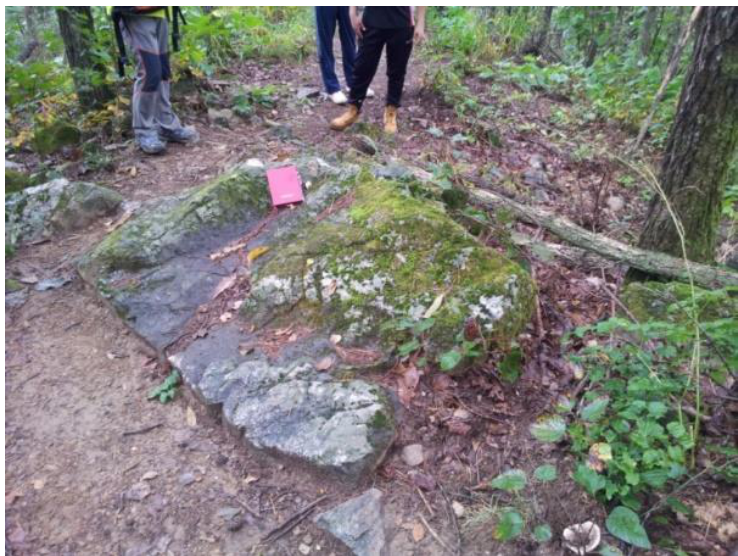
Figure 3. Gneiss outcrop near the top of the mountain.